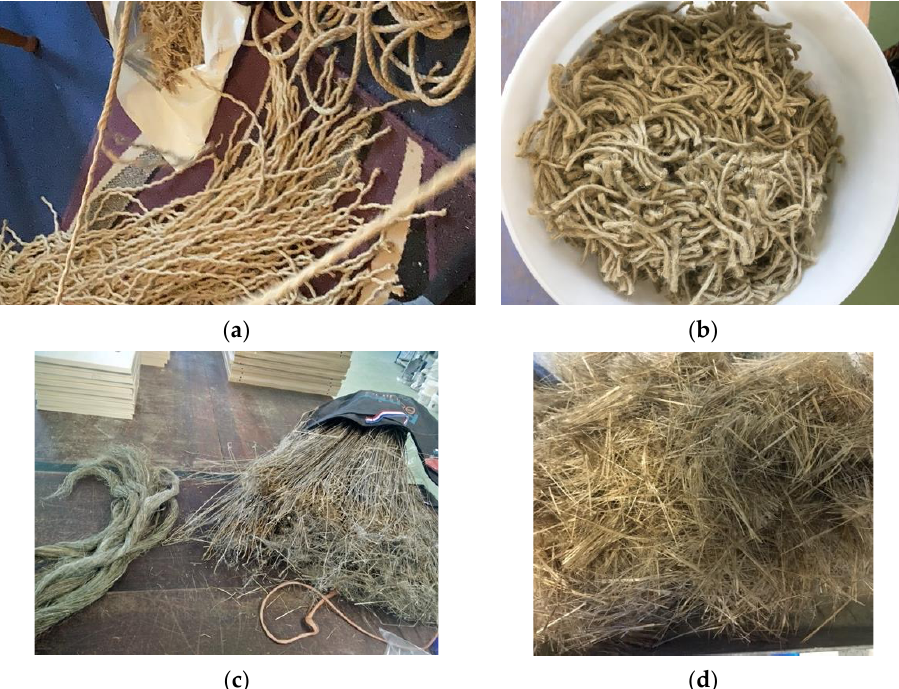
Figure 1. Fibres during separation phase: ( a ) hemp, ( c ) flax. Fibres chopped ( b ) hemp, ( d ) flax.